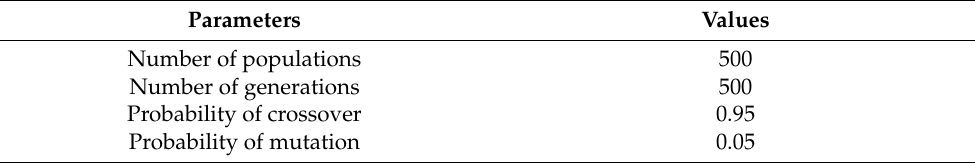
Table 2. Parameters of the GA.